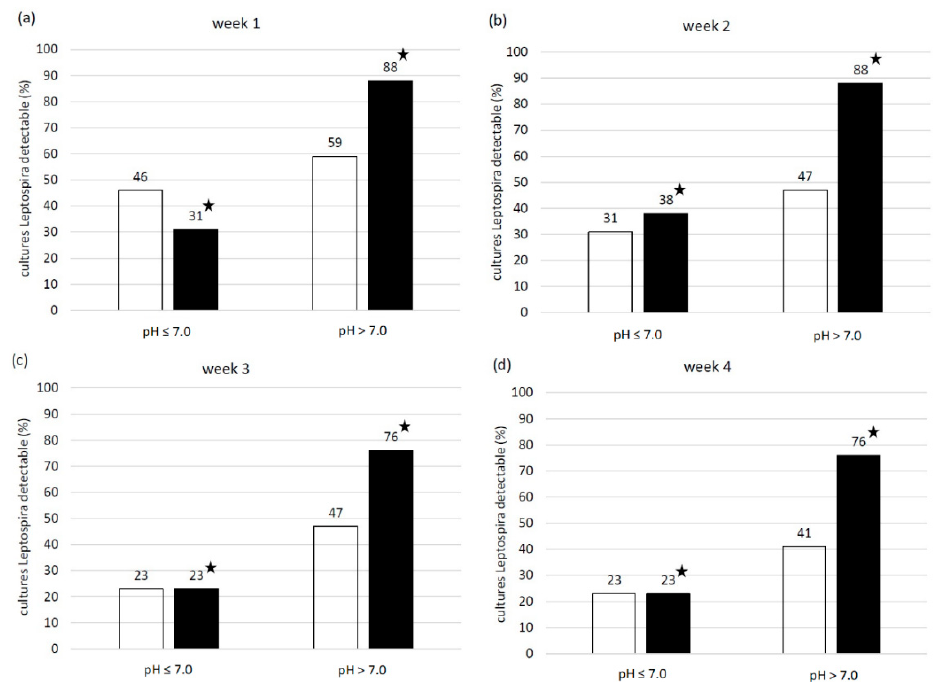
Figure 4. Percentage of □ EMJH and ■ EMJH-STAFF cultures from spiked swine urine samples with pH ≤ 7 and >7 and microscopically (dark field, 200 × ) detectable Leptospira with and without contamination at ( a ) week one, ( b ) week two, ( c ) week three and ( d ) week four post inoculation. ★ significant relationship between urine sample pH and detectability of Leptospira in cultures at the corresponding week of evaluation ( p < 0.01).